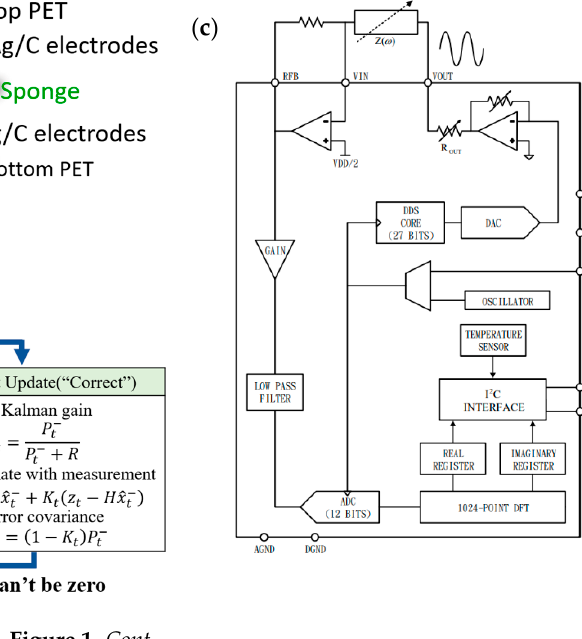
Figure 1. ( a ) Schematic plot and picture of the flexible pressure sensor. ( b ) Operation of the Kalman filter. ( c ) Block diagram. ( d ) Image of the developed impedance readout system. The equation of capacitance with parallel electrodes is listed below as Equation (1). C = 𝑄 𝑉 = 𝜀𝐴 𝑑